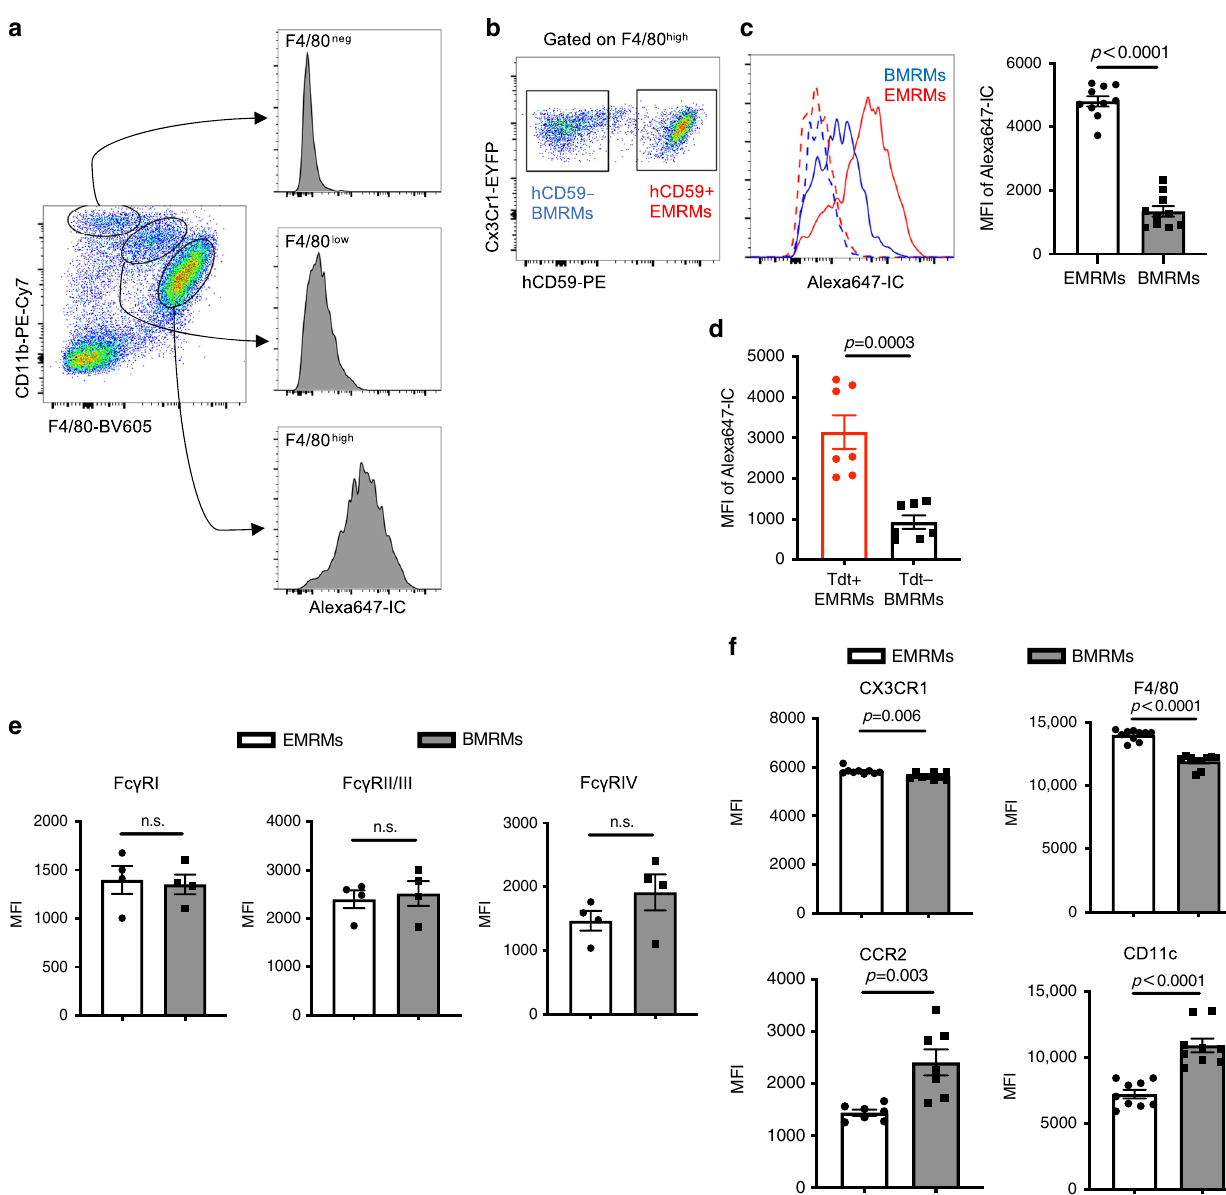
Fig. 6 EMRMs have higher capacity to scavenge immune complex than BMRMS. a Flow cytometry analysis of BSA-R α BSA immune complex (IC)